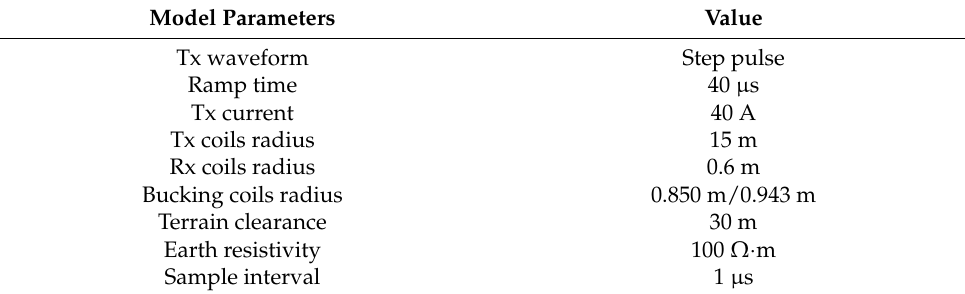
Table 3. Simulation parameters of bucking model.